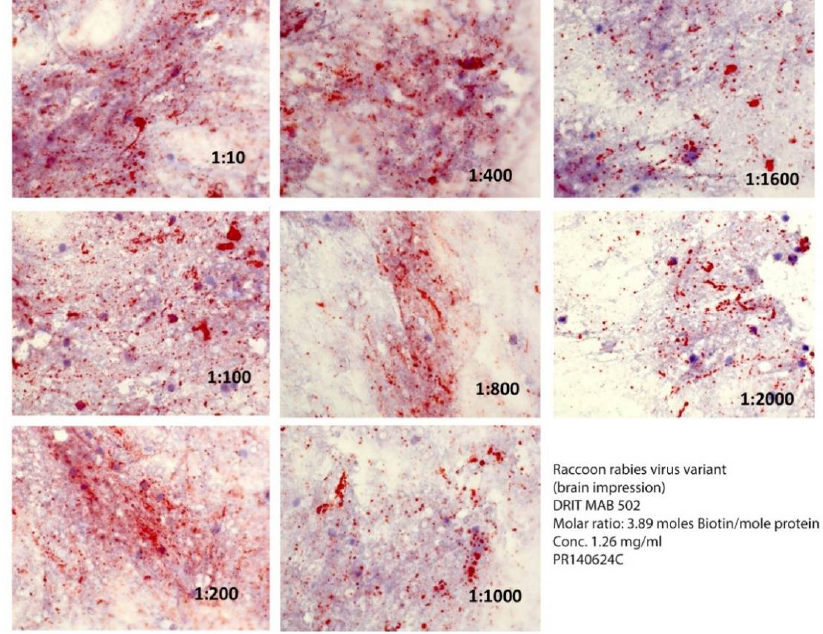
Figure 1. Comparative reactivity of serial dilutions of the DRIT MAB 502 (in PBS) at a ratio of 7.4 moles of biotin per mole of protein against a raccoon rabies virus variant. Rabies virus antigens appear as magenta inclusions against the bluish-purple background of uninfected CNS tissue in Figures 1–3.